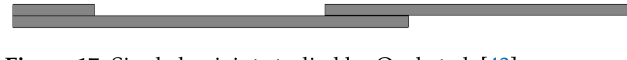
Figure 17. Single lap joint studied by Ozel et al. [43].